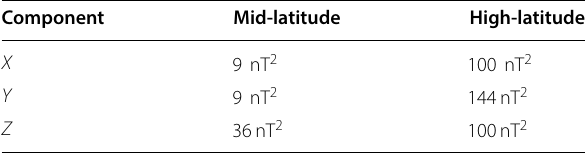
Table 1 Variances prescribed to the three components of mid-latitude (ML) and high-latitude (HL) vector